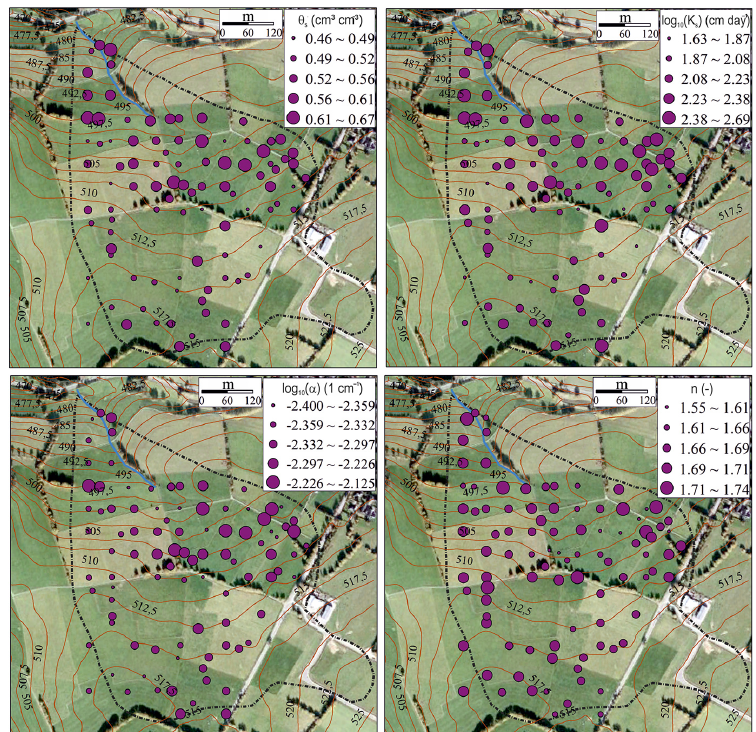
Figure 10. Spatial distribution of soil hydraulic properties ( θ s , log 10 ( K s ), log 10 ( α ), and n ) at 5cm depth derived from soil information obtained from the soil cores taken in the Rollesbroich catchment.